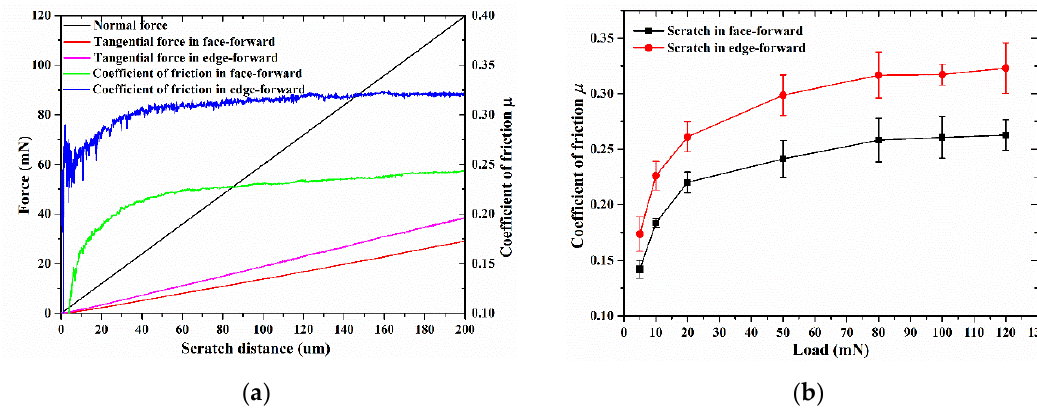
Figure 5. The experimental coefficient of friction (COF) under different scratch directions. ( a ) Normal force, tangential force and COF under ramp loading condition; ( b ) relationship between the normal load and COF under edge and face-forward directions.